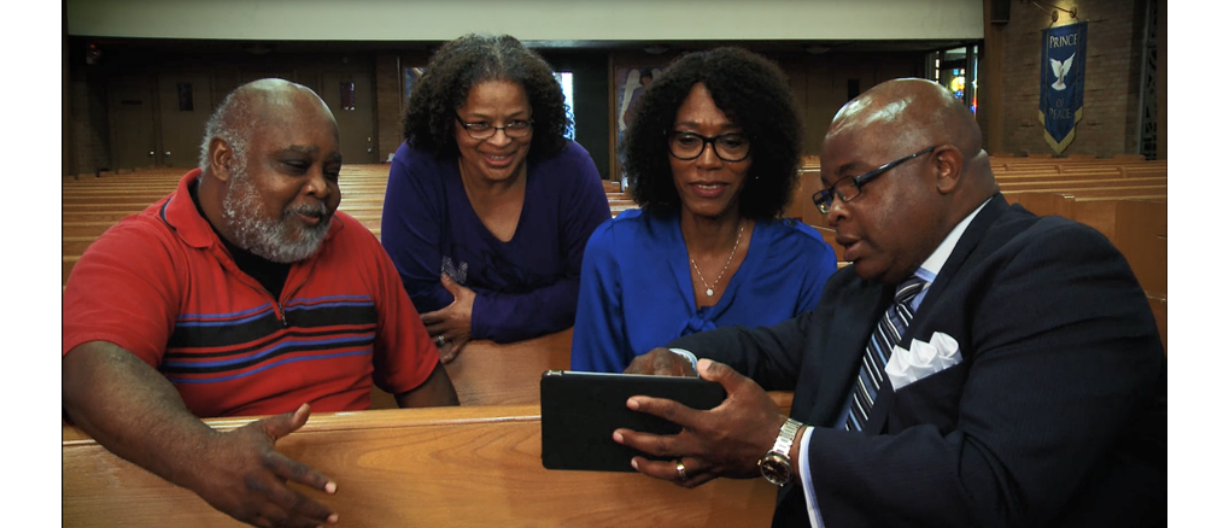
Figure 1. Community members interacting with a community-based mobile health intervention, the FAITH! (Fostering African-American Improvement in Total Health) App . Researchers and African American churches partnered to codevelop the FAITH! App to promote cardiovascular health within faith communities. Used with permission from the Mayo Foundation for Medical Education and